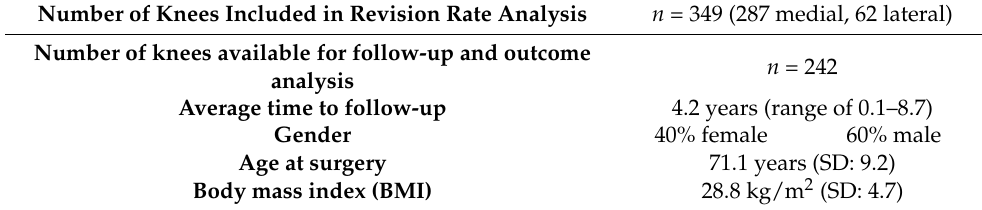
Table 1. Patient demographics. Number of Knees Included in Revision Rate Analysis Number of knees available for follow-up and